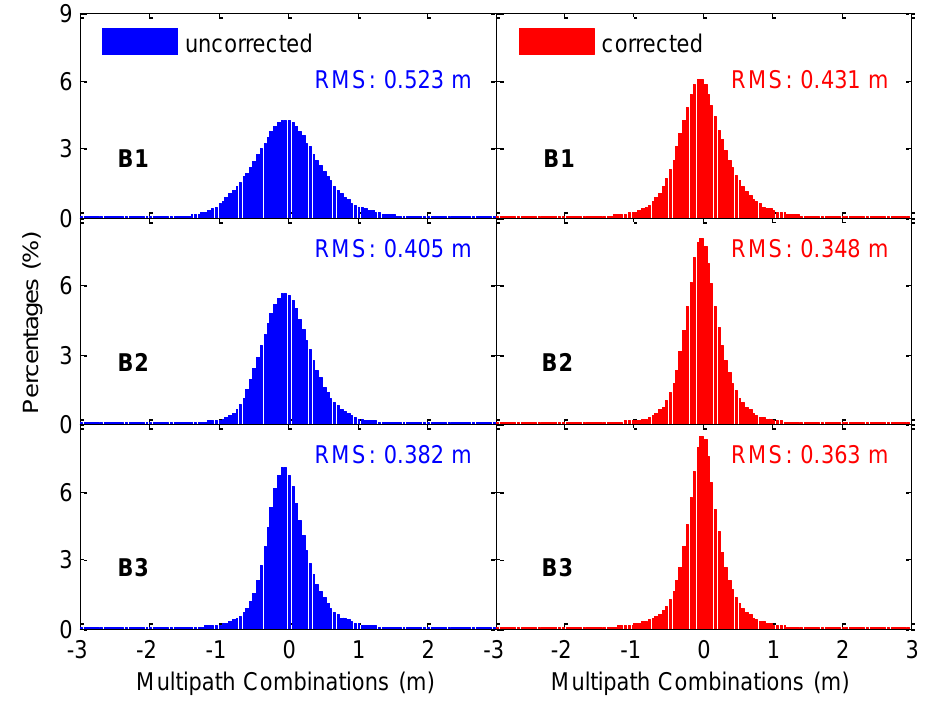
Figure 13. Distribution of uncorrected and corrected MP combination time series for BDS-2 MEO satellites.